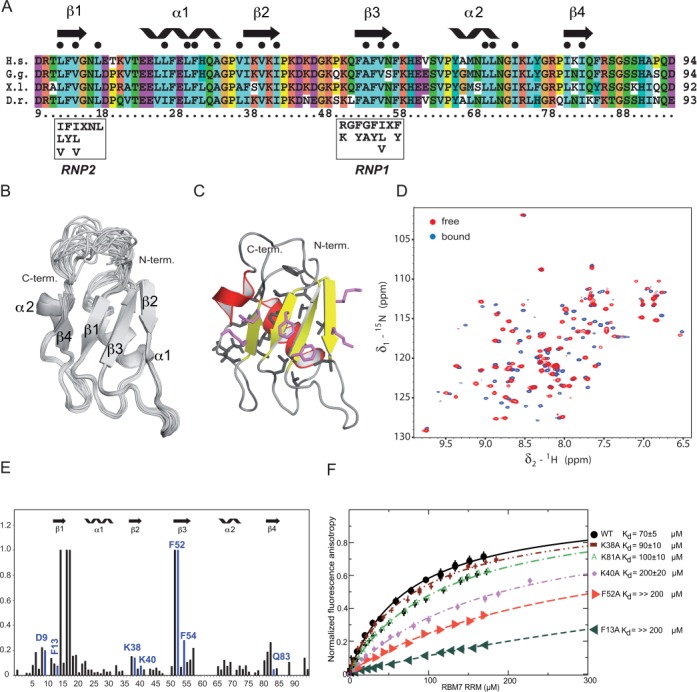
Structural studies and mapping of RNA-interacting residues of the RBM7 RRM. (A) Protein sequence alignment of RRM domains from different vertebrates species. Sequence alignment of RBM7 RRMs from four vertebrate species is depicted with its secondary structure elements and general consensus of RNP1 and RNP2 motifs. H.s. Homo sapiens, G.g. Gallus gallus, X.l. Xenopus laevis, D.r. Danio rerio. (B) Stereo view of the 20 lowest energy structures of RBM7 RRM. The protein backbone is shown as a wire model. (C) Stereo view of the representative (the lowest energy) structure of RBM7 RRM shown as a ribbon diagram. (D) 1H-15N HSQC spectra of RBM7 RRM alone (in red) and in the presence of 1 eq of 5′-CUCUCUC-3′ (in blue) at 303 K. (E) Quantification of chemical shift perturbations of RBM7 RRM upon binding to CUCUCUC RNA. The combined chemical shift perturbations ([ωHNΔδHN]2 + [ωNΔδN]2)1/2, where ωHN = 1 and ωN = 0.154 are weight factors of the nucleus (40), are plotted against the amino acid residue number. Large changes occur on the β-sheet surface. The residues with the chemical shift perturbations equal to one significantly moved at the beginning of titration in 1H-15N HSQC spectra but disappeared with additional RNA aliquots during the titration due to their unfavorable relaxation properties in the complex. Residues selected for site-directed mutagenesis are highlighted in blue. (F) Equilibrium binding of RBM7 RRM mutants with fluorescently labeled polypyrimidin RNA monitored by fluorescence anisotropy. Indicated RRM mutants of RBM7 along with the wild type of RBM7 RRM were titrated with fluorescently labeled CUCUCUC substrate. Binding isotherms and dissociation constants (Kd) are shown for each mutant.